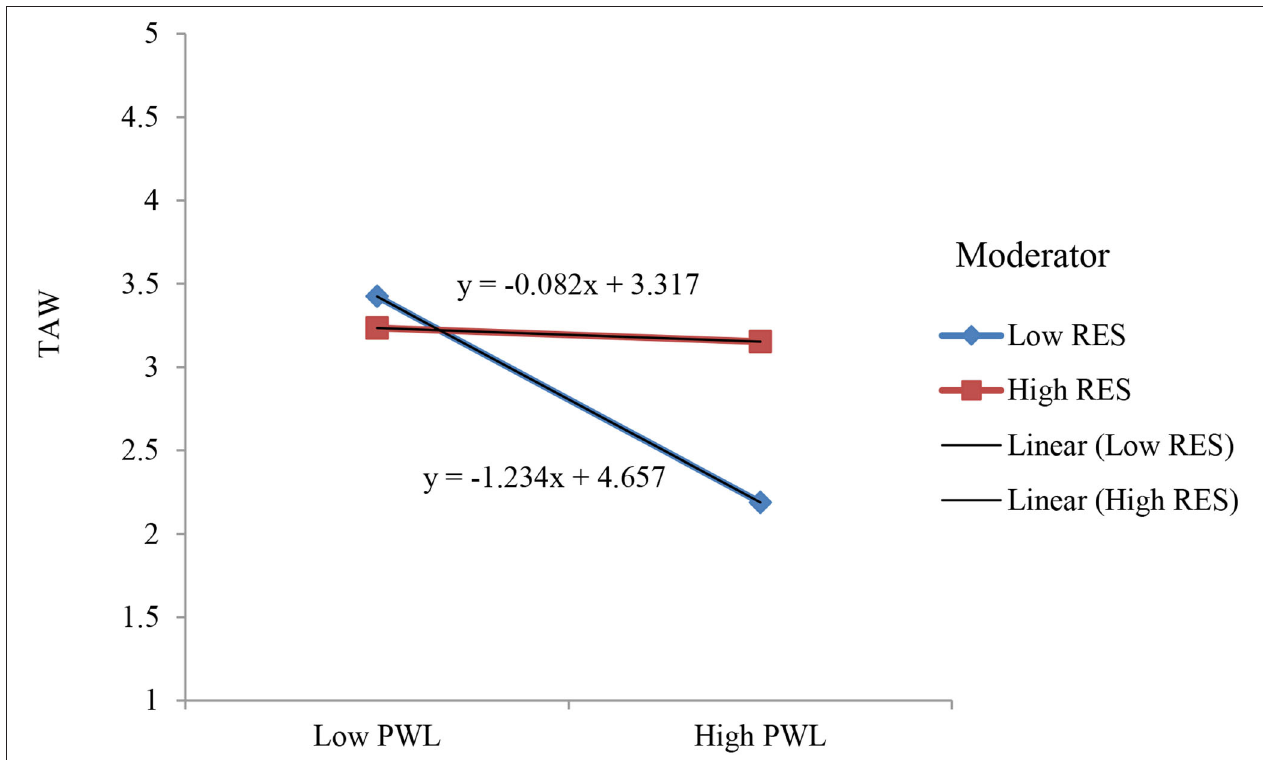
FIGURE 3 | Resilience’s moderating effect on TAW through perceived workload